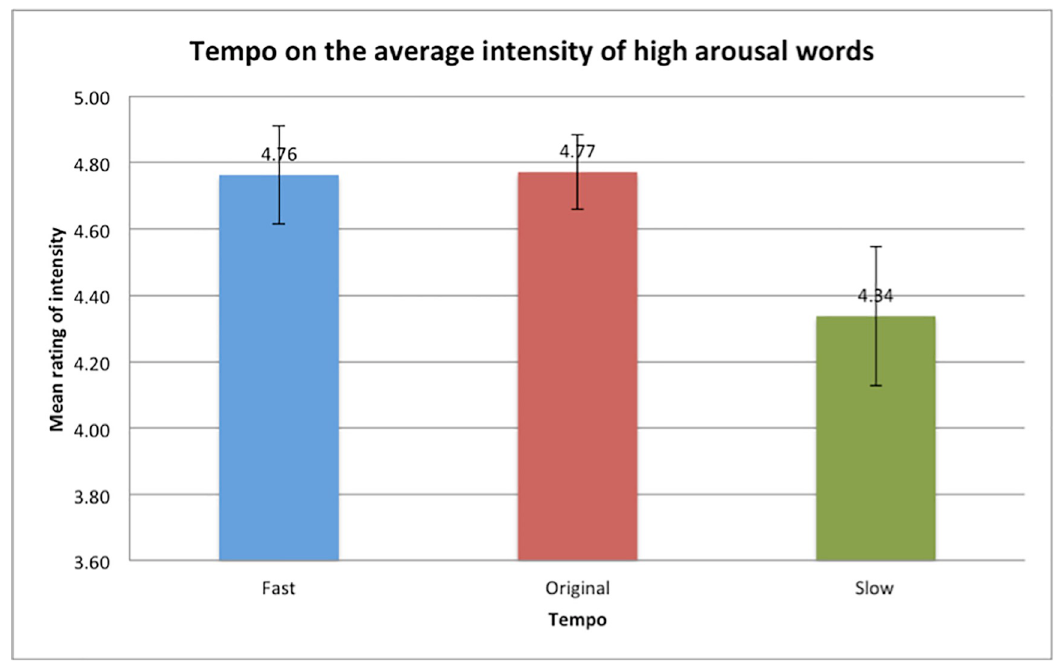
Fig 12. Average rated intensities of tempo on the high arousal words. Error bars indicate the standard error of the means.